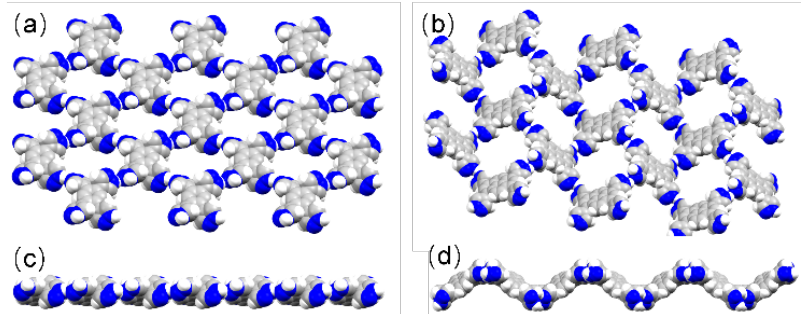
Figure 2. View of the connection of adjacent building blocks in the Crystal structure of HOF-1 ( a , c ) and HOF-2 ( b , d ).